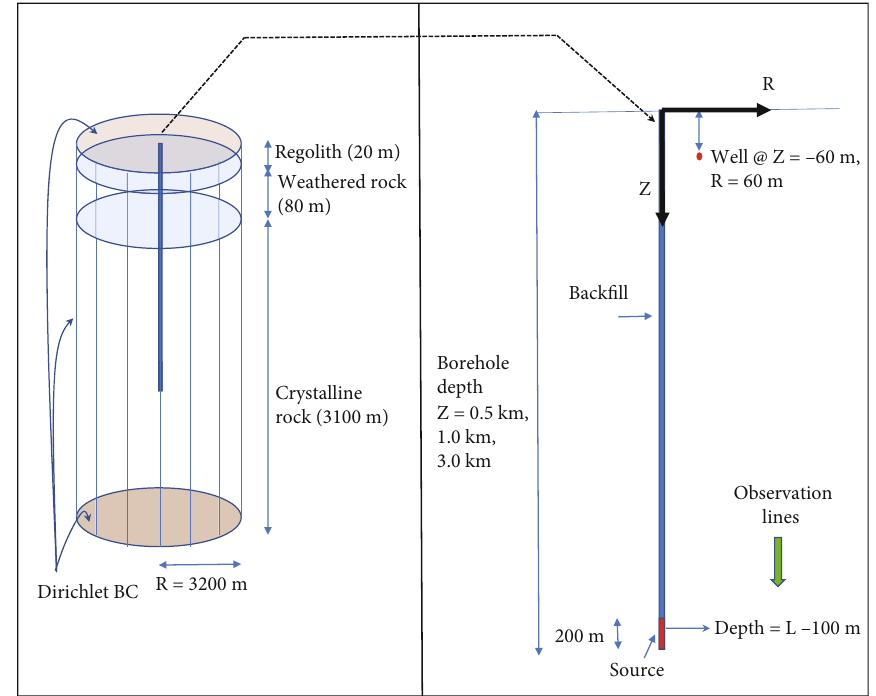
Figure 2: (left) Conceptual site model; (right) borehole with data sampling locations (well, observation